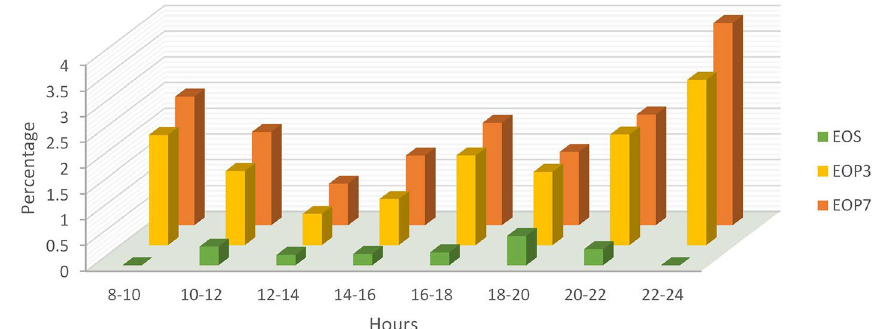
Figure 2. Length of time from rupture of membranes to delivery is categorized into 2-h groups and rates of EOP in 3 days of life, EOP in 7 days of life and